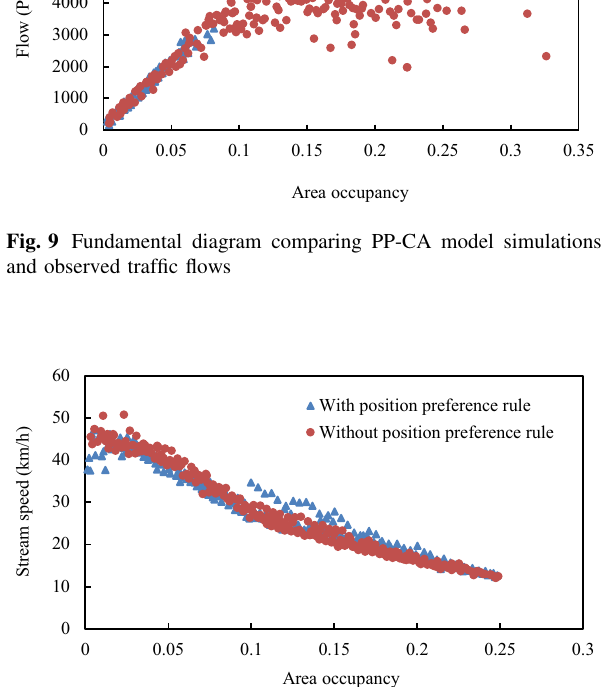
Fig. 10 Relationship between area occupancy and stream speed obtained using position preference based modified